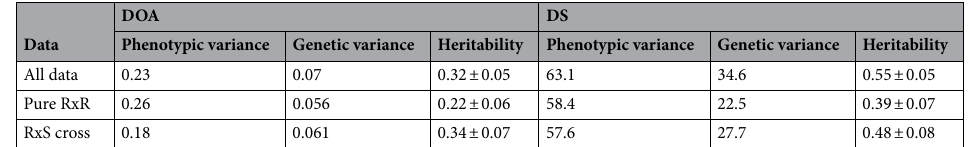
Table 1. Estimated variance components and heritabilities for both traits from analysing the G 0 -data together or each genetic group (purebred or crossbred) separately.